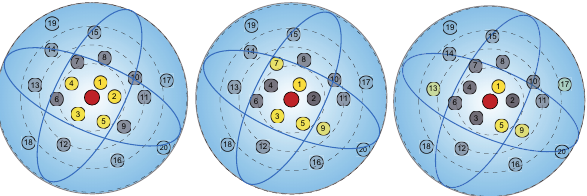
Figure 5. Nearest neighbor selection of dilated k -NN [52]. The number in the circle represents the distance from center point (red). k -NN, where k = 5, with different dilation rates 1, 2 and 4 (left to right) selecting different points (yellow) as relative points.